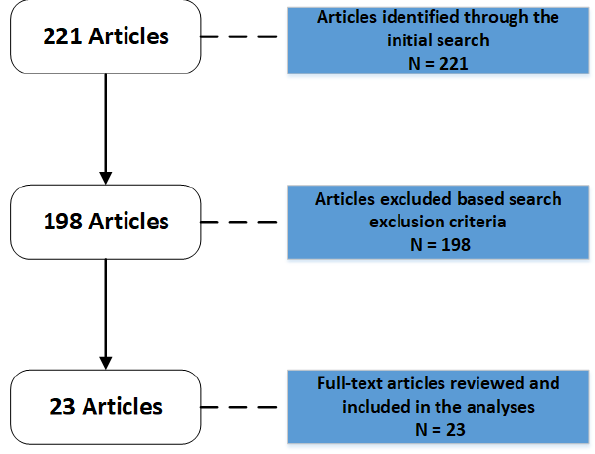
Figure 1. Article Selection Based on Search.